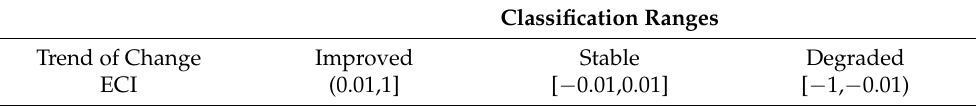
Table 5. Classification ranges of ECI.